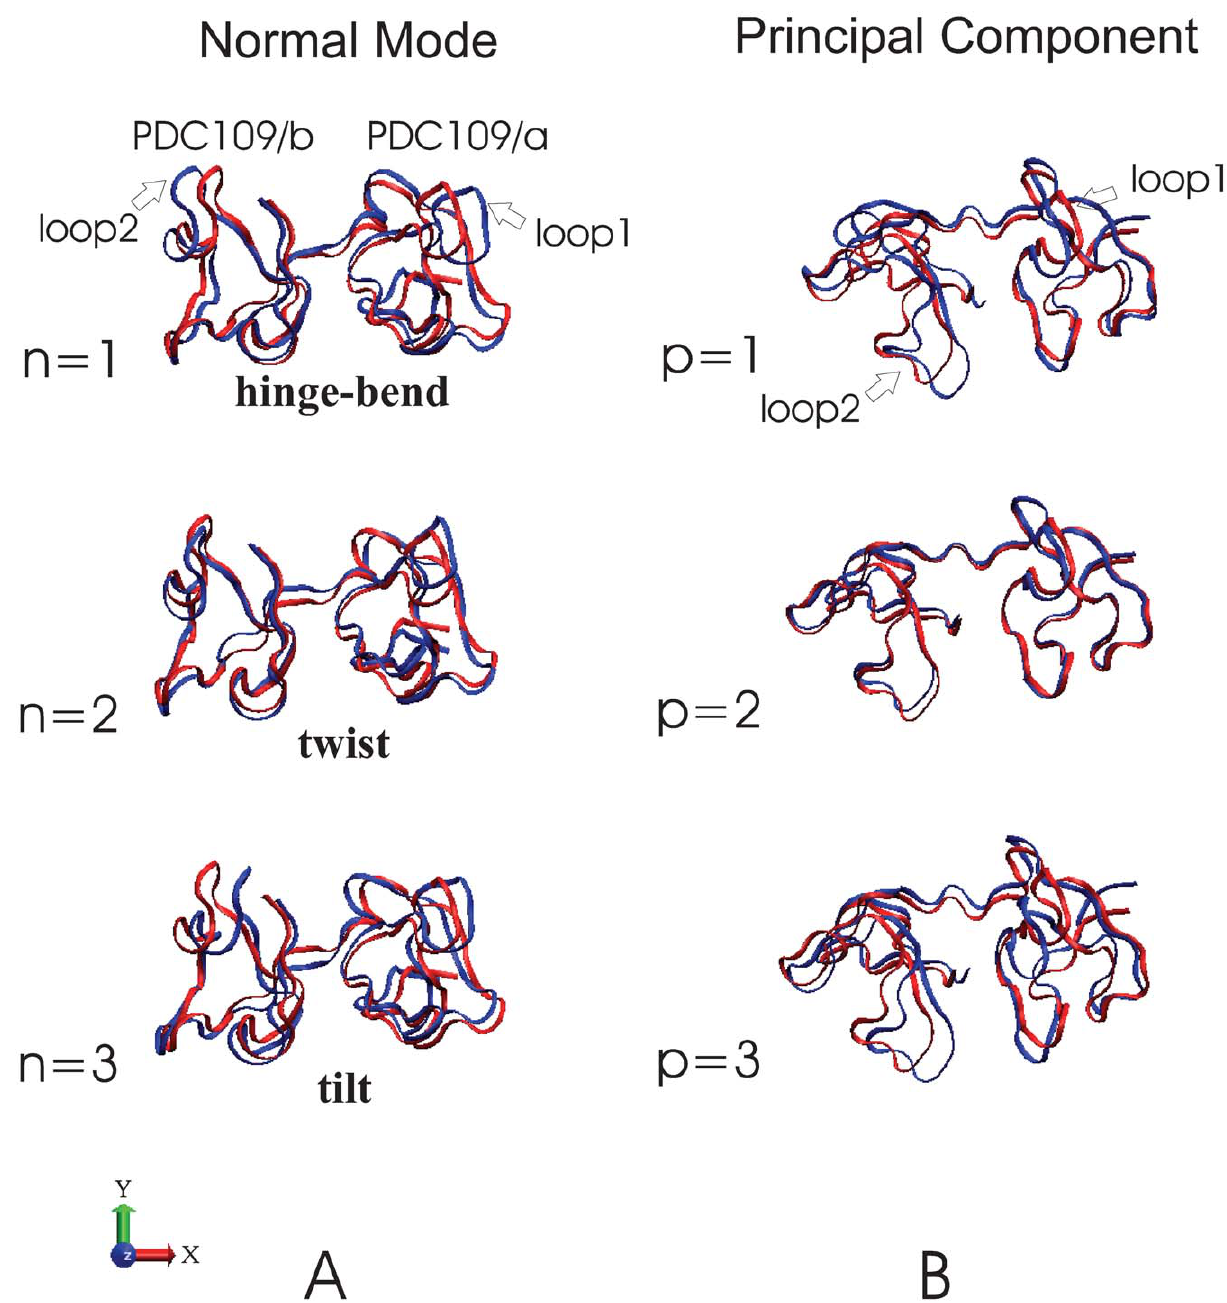
Figure 12. Comparison of the first three normal modes and principal components. Overlapping ribbon conformations for the three lowest normal modes are shown at t=0 (red) and t ~ 2 p = 3 n (blue) with the normalized eigenvector vibrational amplitudes scaled by a factor of 200. The normal mode index n corresponds to specific vibrational frequencies as follows: n =1 (hinge-bend), n ~ 0.80 cm { 1 ; n =2 (twist), n ~ 1.72 cm { 1 ; n =3 (tilt), n ~ 3.08 cm { 1 . Overlapping ribbon conformations for the three largest amplitude principal components (p=1, 2, 3) are shown with the reference structure (red) as displacements scaled by a factor of 200 standard deviations along each principal component (blue) [74]. doi:10.1371/journal.pone.0009180.g012 frequency NMs. To evaluate the relatedness between PCs and compared to NMs calculated in vacuum. Compared to NM, loop NMs, PCs with the three largest eigenvalues were projected onto all NMs of PDC109 as shown in Fig. 13. These projected values obtained from the 400 ns trajectory where the two domains mostly are displayed for n v 1000 with insets magnifying values for n v 24. We find that PCs with large eigenvalues are highly correlated to low frequency NMs. The n = 1 and n= 2 NMs account for 19.1% and 16.5% of the first PC, respectively. The